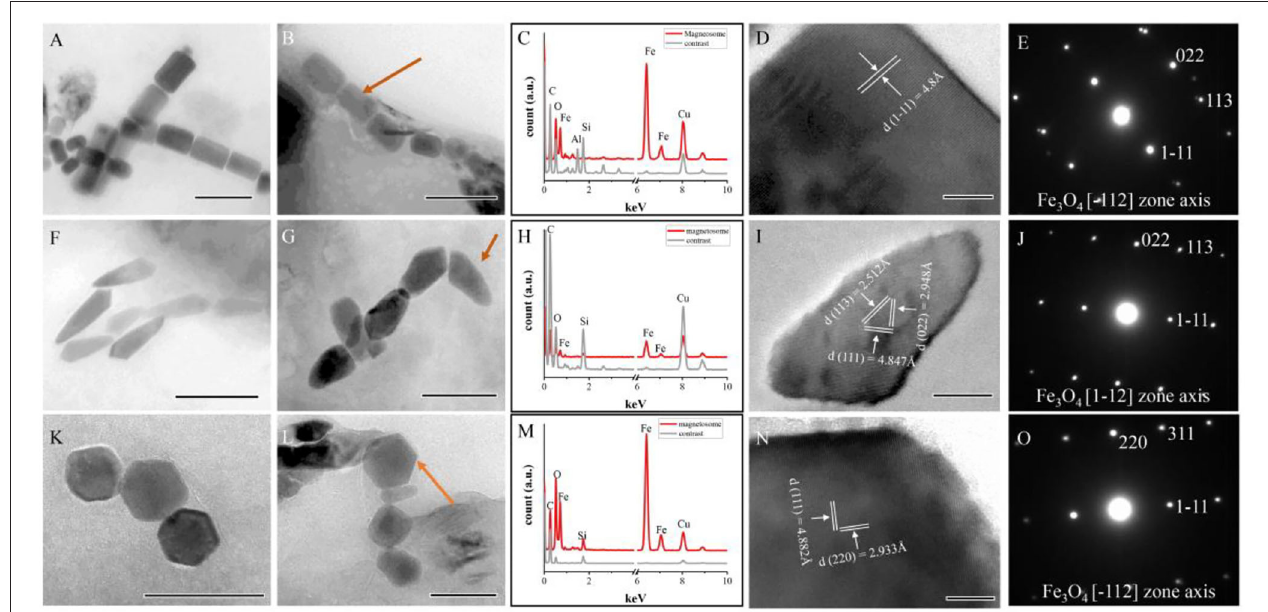
FIGURE 4 | Characteristics of magnetofossils with three main shapes. (A,B) Elongated-prismatic magnetofossils. (C–E) Energy dispersive X-ray spectra (C) , HRTEM image (D) , and electron diffraction patterns (E) of the magnetofossil indicated by an arrow in panel (B) . (F,G) Bullet-shaped magnetofossils. (H–J) Energy dispersive X-ray spectra (H) , HRTEM image (I) , and electron diffraction patterns (J) of the magnetofossil indicated by an arrow in panel (G) . (K,L) Cuboctahedron magnetofossils. (M–O) Energy dispersive X-ray spectra (M) , HRTEM image (N) , and electron diffraction patterns (O) of the magnetofossil are indicated by an arrow in panel (L) (cuboctahedron magnetofossil). Scale bars (A,B,F) 200 nm; (G,K,L) 100 nm; (I) 20 nm; and (D,N) 10 nm.